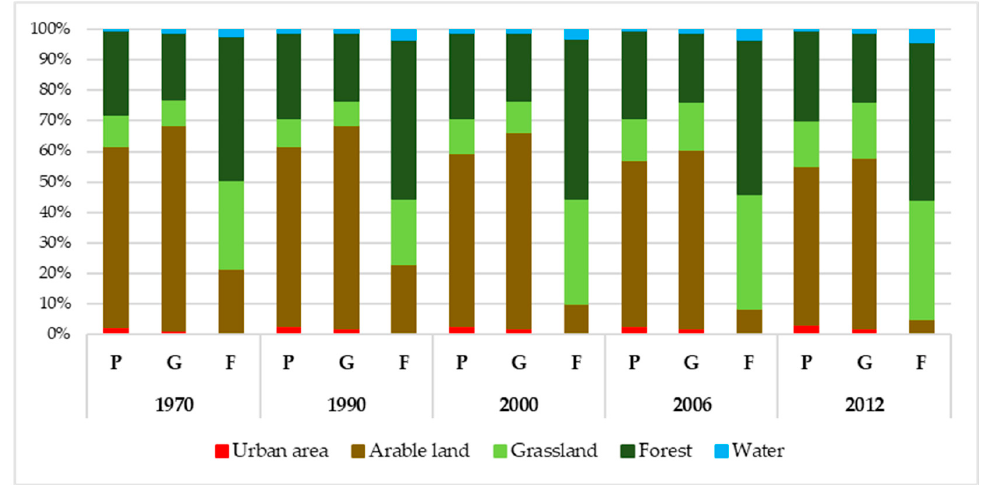
Figure 7. Average percentage values of land use categories represented by region of production (P—potato, G—grain, F—forage) for individual years based on an analysis of actual land use according to the Corine Land Cover.